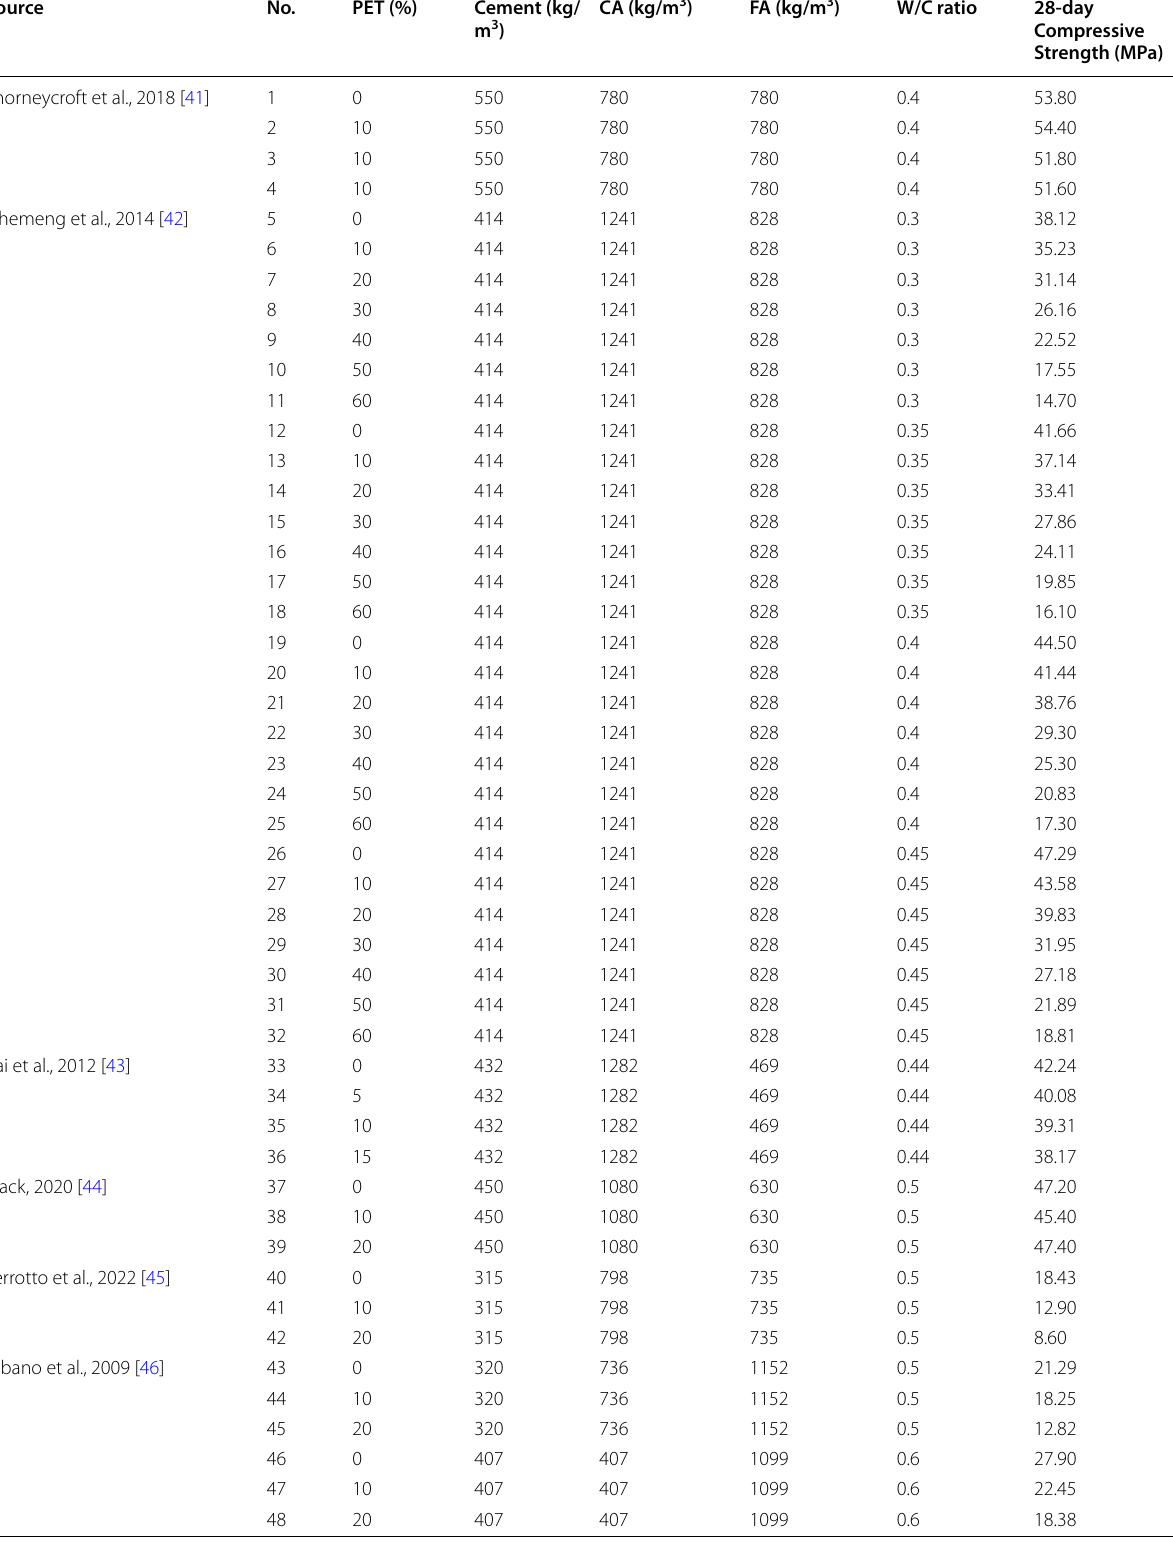
Table 2 Literature for PET-FA